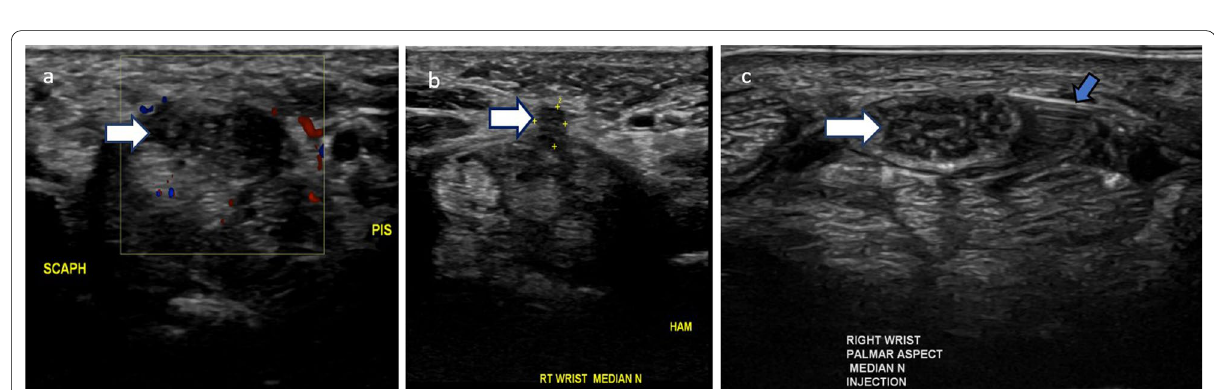
Fig. 12 Features and management of carpal tunnel syndrome on ultrasound are illustrated. a , b : 35-year-old female with carpal tunnel syndrome. The typical ultrasound appearance for neuropathy includes hypoechoic enlargement and nerve swelling ( a , white arrow). There is an incidental variant of the recurrent branch of the median nerve that pierces the transverse carpal ligament ( b , white arrow). c : Perineural cortisone injection of the median nerve under ultrasound guidance is shown. The needle (blue arrow) is positioned superficial and to the right side of the nerve (white arrow), with injectate encircling the